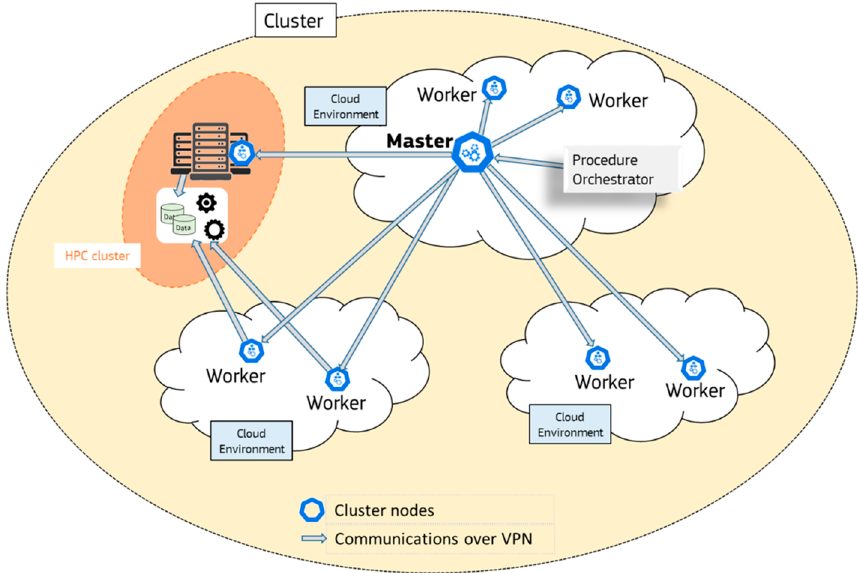
Figure 8. Centralized orchestration architecture for implementing a multi-cloud DE .